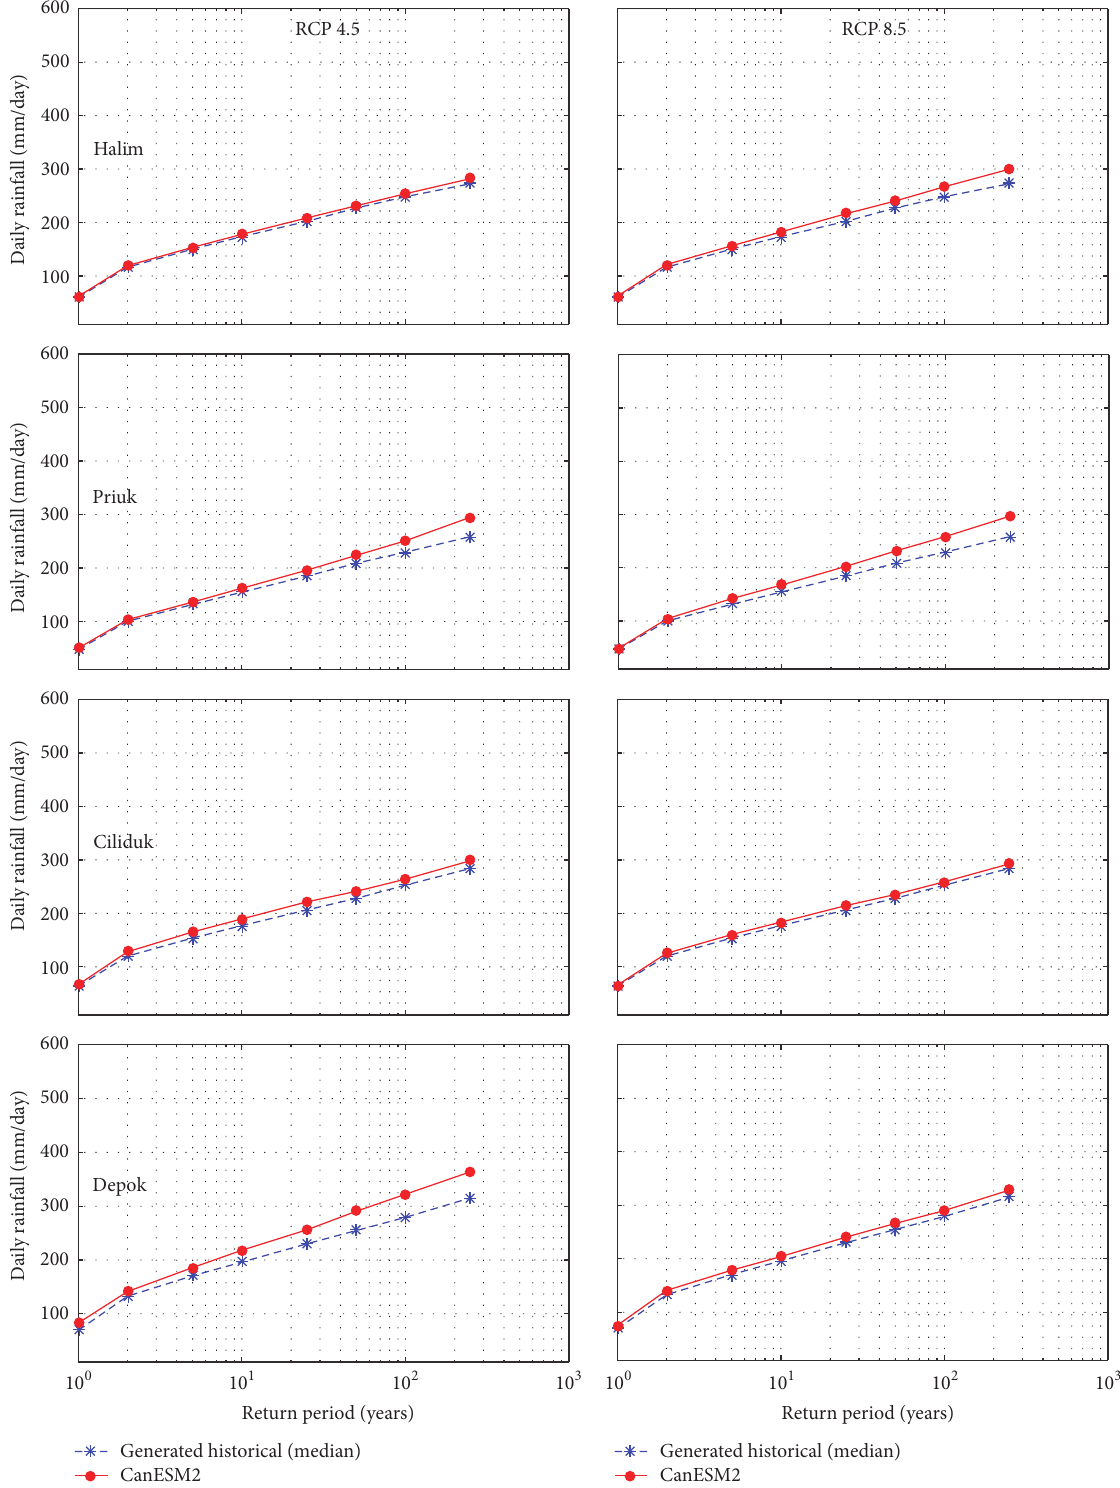
Figure 9: Comparison between GCM predictions for future (2046–2068) and historical generated rainfall from SDSM for ARF 5 emission scenarios RCP 4.5 and RCP 8.5. The RP curves are generated with daily annual maximum